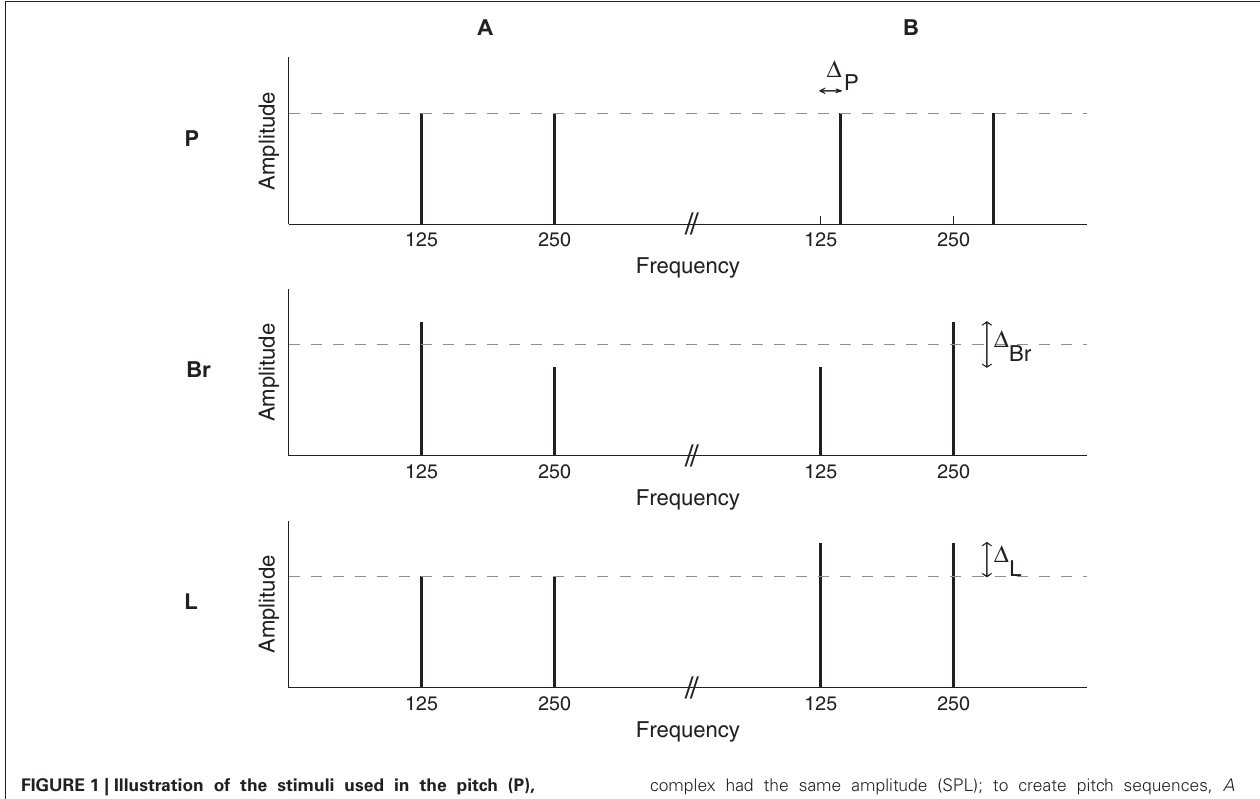
FIGURE 1 | Illustration of the stimuli used in the pitch (P), brightness (Br), and loudness (L) conditions. The long-term spectra of the stimuli are schematized. For all conditions, individual sounds were two-tone complexes, with a one-octave frequency ratio. Sequences were constructed by the random succession of A and B complexes, which differed along a given dimension for each of the three conditions. In the P condition, the two components of each